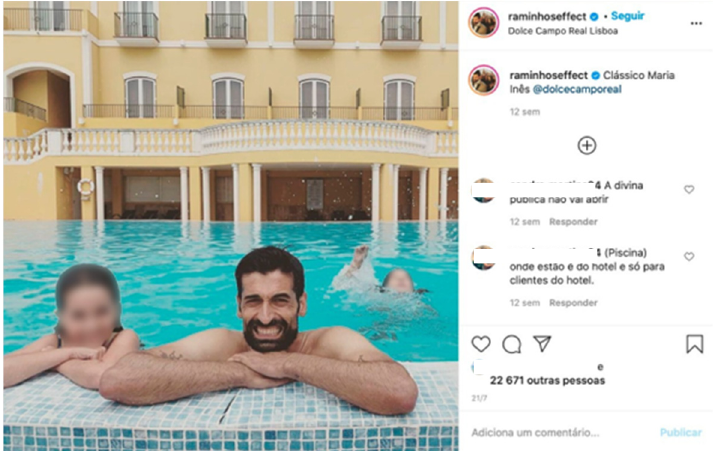
Figure 2. Example of “Outdoor: outings and tours”; Instagram @raminhoseffect, Post, 21 July 2020.